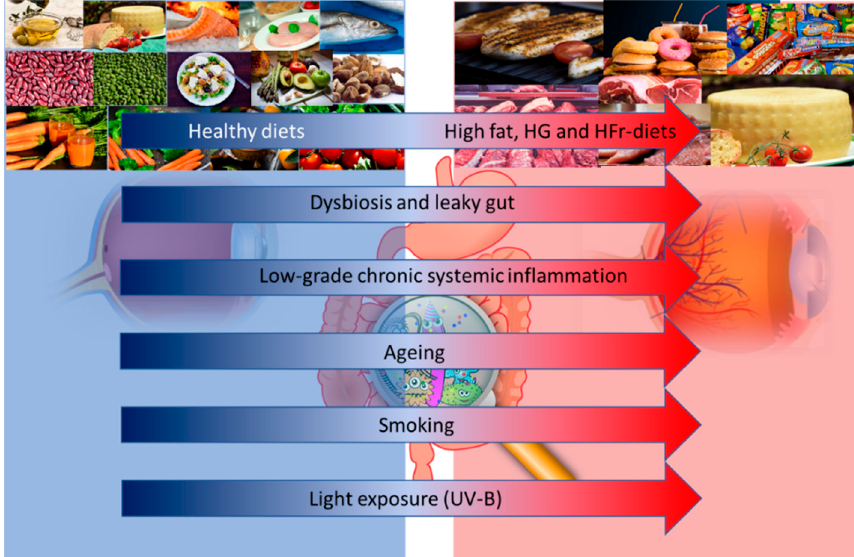
Figure 1. Altered dietary habits, dysbiosis and leaky gut, and low grade inflammation, together with aging, smoking and light exposure may influence the risk and progression of age-related macular degeneration (AMD). Abbreviations: HG: High Glucose; HFr: High Fructose; UV-B: Ultraviolet-B.